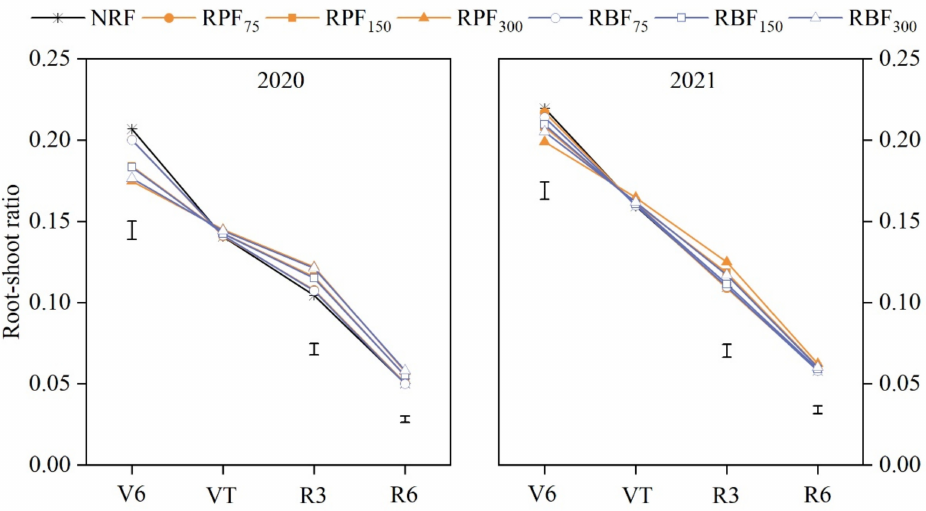
Figure 8. Effects of different treatments on spring maize root–shoot ratio in 2020 and 2021 growing seasons. Vertical bars stand for LSD at 0.05